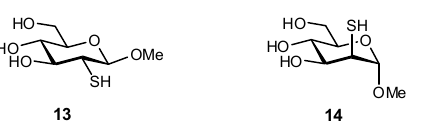
Figure 6. Propylamycin ( 18 ) is a glycomimetic that has shown excellent antibiotic efficacy against several important drug-resistant Gram-negative pathogens. The propyl substituent is believed to